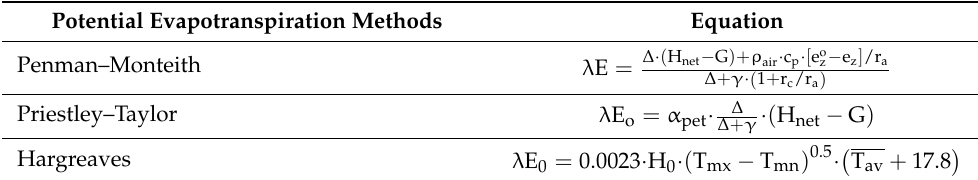
Table 1. Potential evapotranspiration models